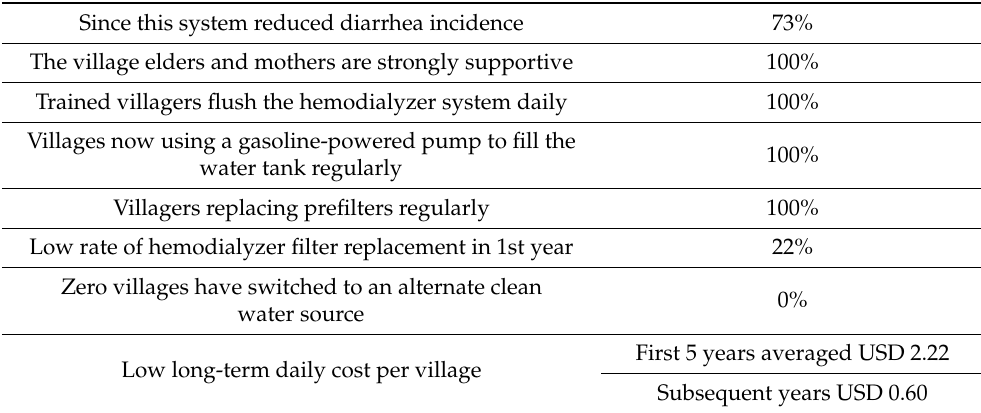
Table 1. Factors supporting long-term